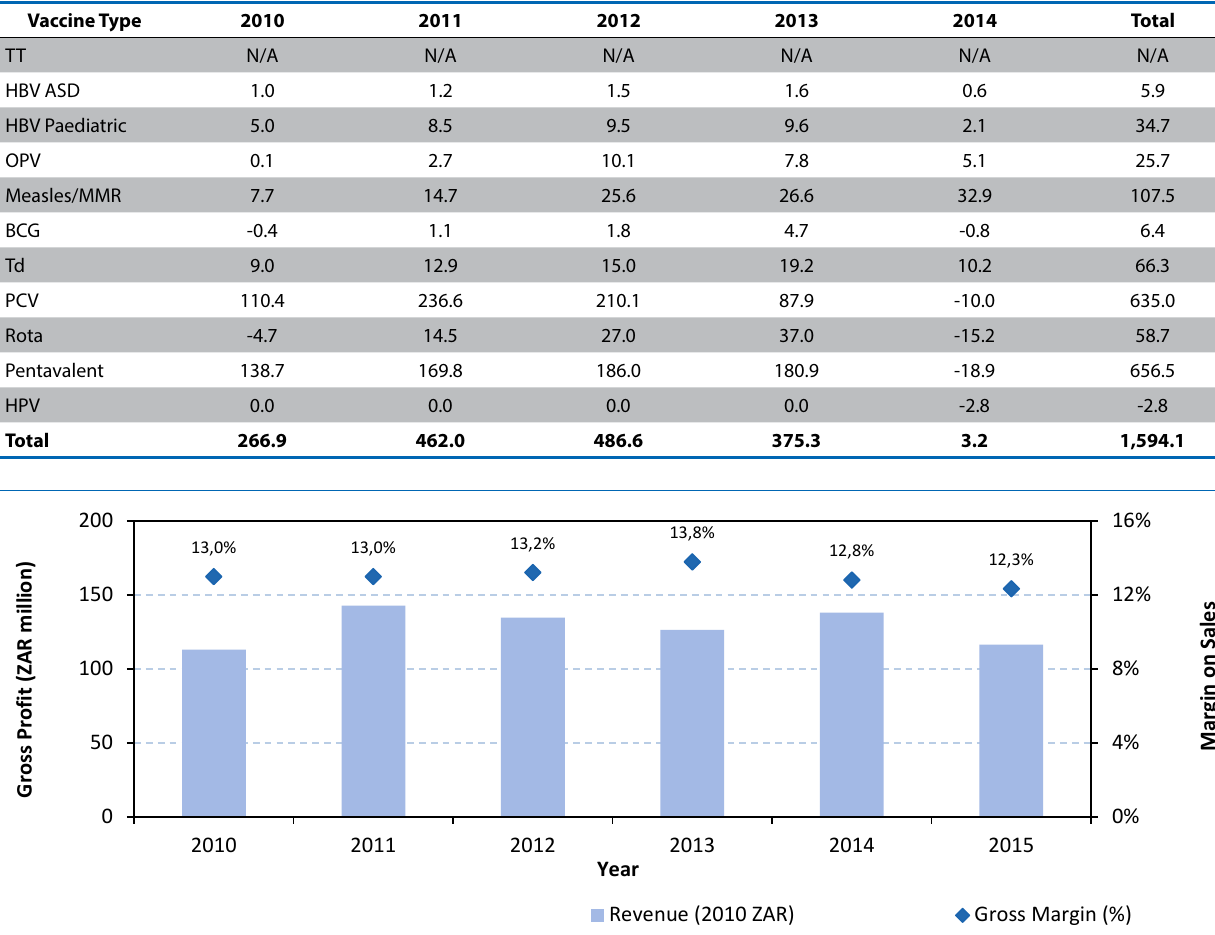
Figure 3. Gross profit and margin over the evaluation period